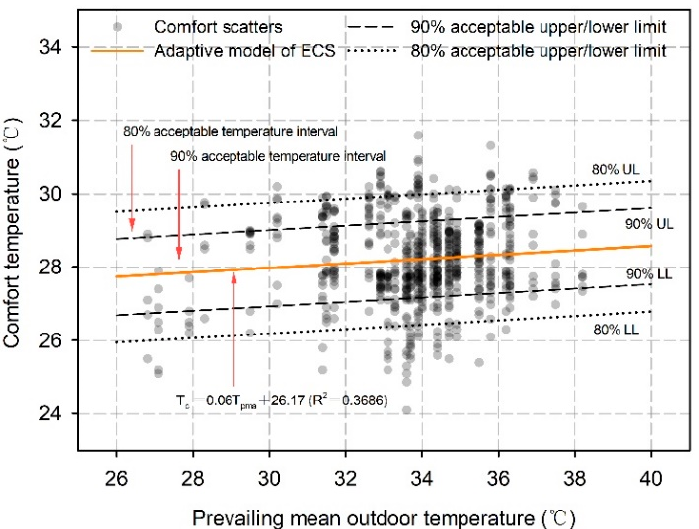
Figure 13. The relationship between indoor comfort temperature and prevailing mean outdoor tem- perature in